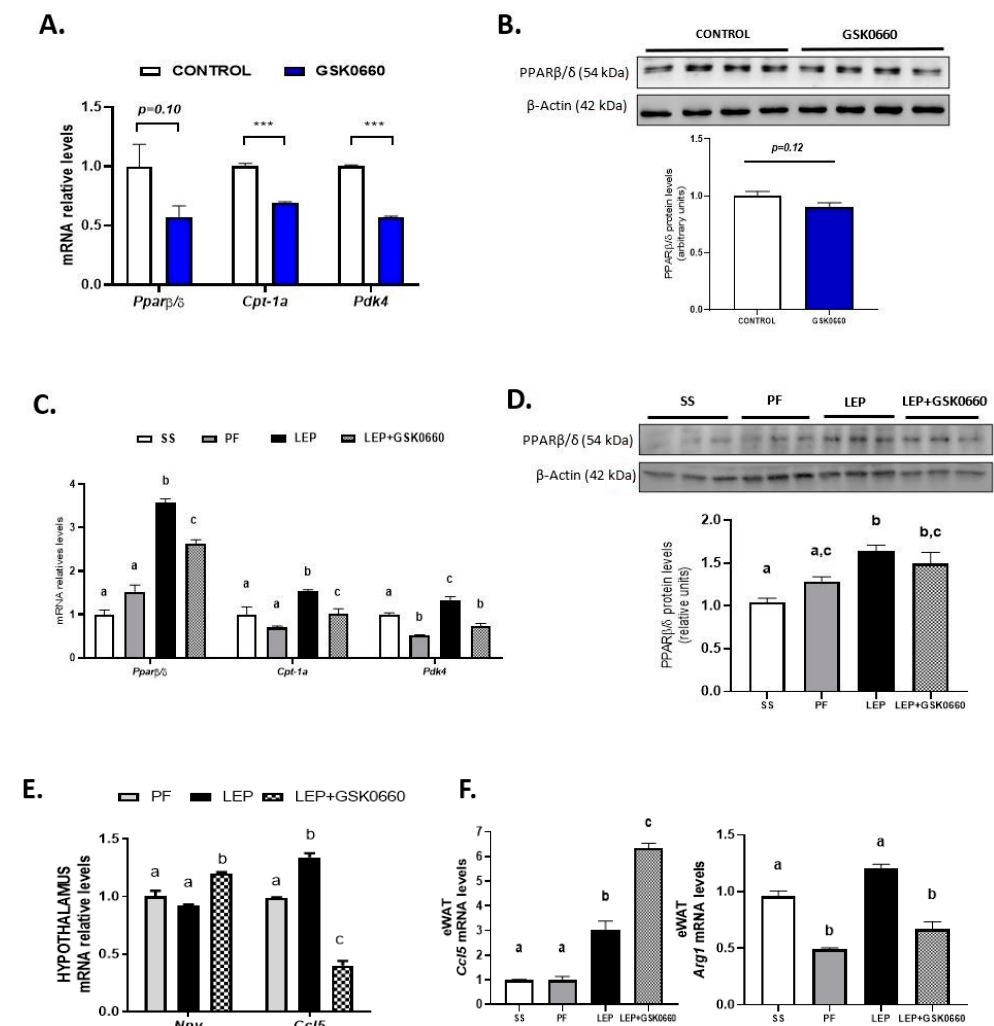
Figure 2. ( A ) Effect of vehicle (DMSO) control or antagonist ip GSK0660 administration on eWAT mRNA levels of Ppar β / δ , Cpt1a, and Pdk4 of rats after 7 days of intraperitoneal injection ( n = 6). ( B ) Representative Western Blot and relative densitometric analysis of PPAR β / δ total protein content in eWAT of rats after 7 days of vehicle (DMSO) control or ip GSK0660 injection ( n = 6). ( C ) Effect of icv vehicle (SS and PF), leptin, or leptin and ip GSK0060 co-administration on eWAT mRNA levels of Ppar β / δ , Cpt1a and Pdk4 in rats after 7 days of chronic treatment ( n = 4–6). ( D ) Representative Western blot and relative densitometric analysis PPAR β / δ total protein content in eWAT in rats after 7 days of chronic central treatment of vehicle (SS and PF), leptin, or leptin and ip GSK0660 co-administration ( n = 4–6). ( E ) Hypothalamus mRNA levels of Npy and Ccl5 in rats after 7 days of chronic central treatment of vehicle (SS and PF), leptin, or leptin and ip GSK0660 co-administration. ( F ) eWAT mRNA levels of Ccl5 and Arg1 in rats after 7 days of chronic central treatment of vehicle (SS and PF), leptin, or leptin and ip GSK0660 co-administration. Data from real-time RT-PCR are expressed relative to 18S rRNA and the mRNA levels are expressed relative to the control (DMSO) group and vehicle SS group, the level of which was set at 1.0 arbitrarily. In Western blot analysis, densitometric levels of proteins are expressed relative to the control group and SS group, the levels of which were set at 1.0 arbitrarily. Results are the mean ± SEM per group of animals ( n = 4–6). Differences between CONTROL vs. GSK0660 treatment were analyzed by Student’s t -test (*** p < 0.001). Significant differences between ICV-treated rats were analyzed by One-Way ANOVA followed by Tukey test (differences letters mean significant differences among treatments, p ≤ 0.05). a p ≤ 0.05 vs. Lep or Lep+GSK0660; b p ≤ 0.05 vs. SS or PF or Lep+GSK0660; c p ≤ 0.05 vs. SS or PF or Lep or Lep+GSK0660. SS: vehicle-infused rats fed ad libitum; PF: vehicle-infused pair-fed rats; Lep: leptin-infused rats; Lep+GSK0660: leptin-infused rats plus PPAR β / δ antagonist